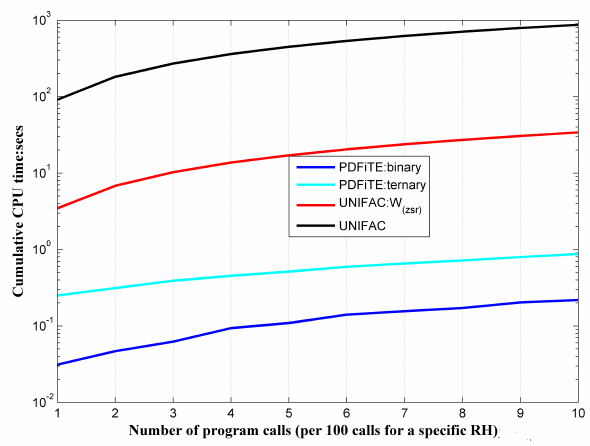
Fig. 6. Cumulative CPU time for each 100’th call of each activity coefficient model. Two variations of the UNIFAC model correspond to using the same water content as calculated in PD-FiTE (using ZSR “ W ZSR ” and using an iterative solver).